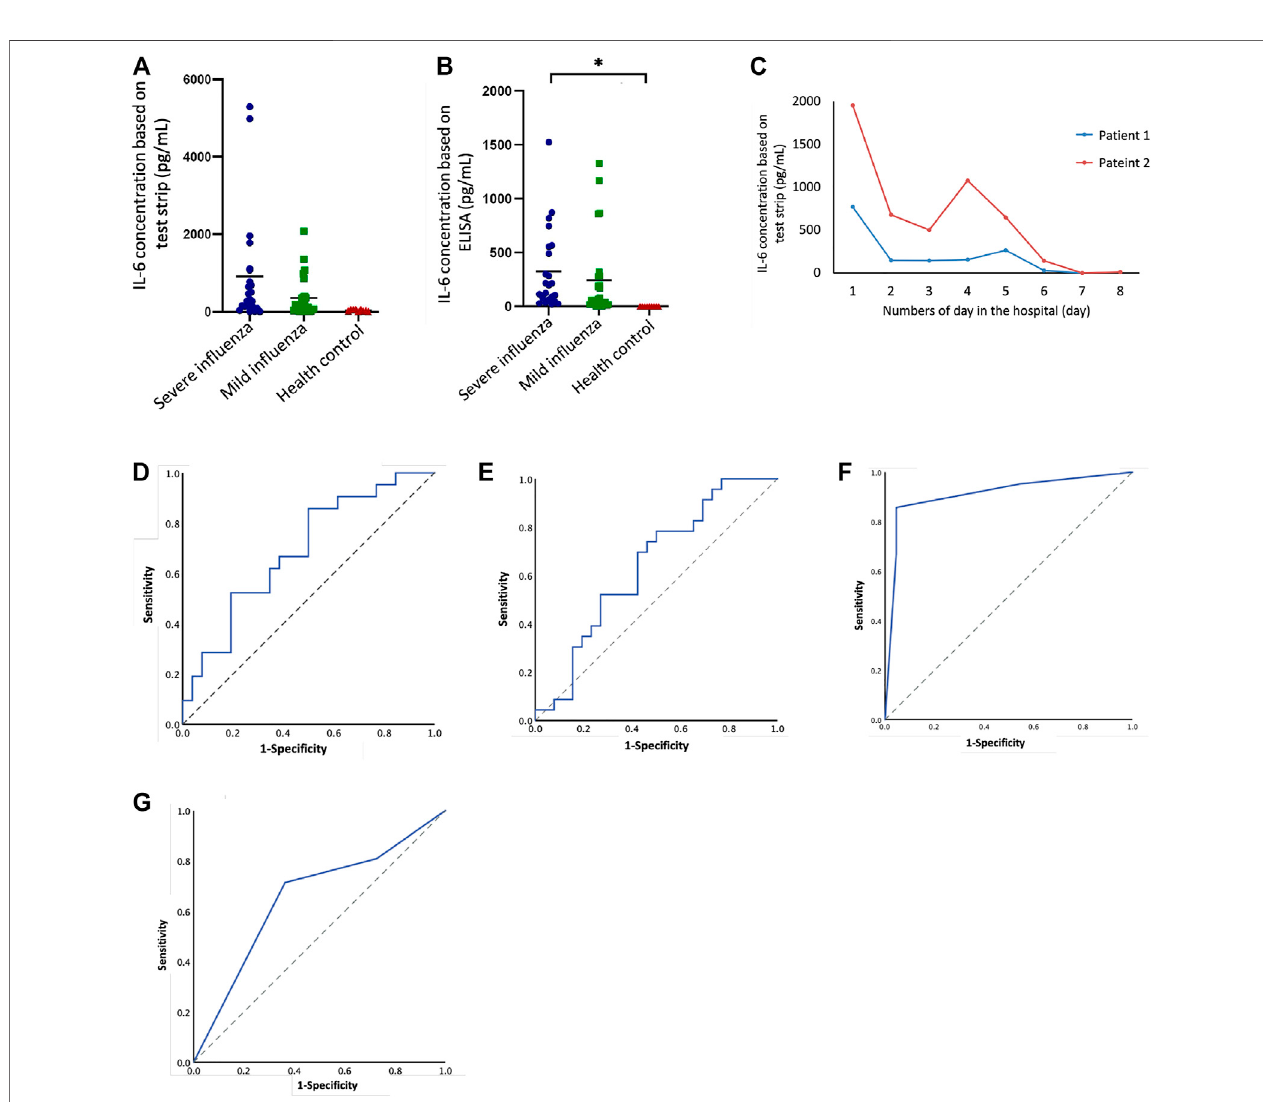
FIGURE 3 | IL-6 levels in severe cases and mild cases of in fl uenza in children based on test strip and ELISA. (A) IL-6 (test strip) concentration between different groups: severe in fl uenza (n (cid:1) 23), mild in fl uenza (n (cid:1) 26), health control (n (cid:1) 10). (B) IL-6 (ELISA) concentration between different groups: severe in fl uenza (n (cid:1) 23), mild in fl uenza(n (cid:1) 26),healthcontrol(n (cid:1) 10).Therewasastatisticallysigni fi cantdifferencebetweenseverecasesandhealthycontrols( p < 0.05). (C) Follow-upIL-6teststrip concentrationscomparedtonumberofdaysinthehospitalfortwopatients. (D) ROCcurveofIL-6concentration(teststrip),AUC (cid:1) 0.69, p (cid:1) 0.026. (E) ROCcurve of IL-6 concentration (ELISA), AUC (cid:1) 0.64, p (cid:1) 0.092. (F) ROC curve of IL-6 concentration (test strip) combined with CRP, AUC (cid:1) 0.911, p (cid:1) 0.00. (G) ROC curve of IL-6 concentration (ELISA) combined with CRP, AUC (cid:1) 0.654, p (cid:1) 0.085.